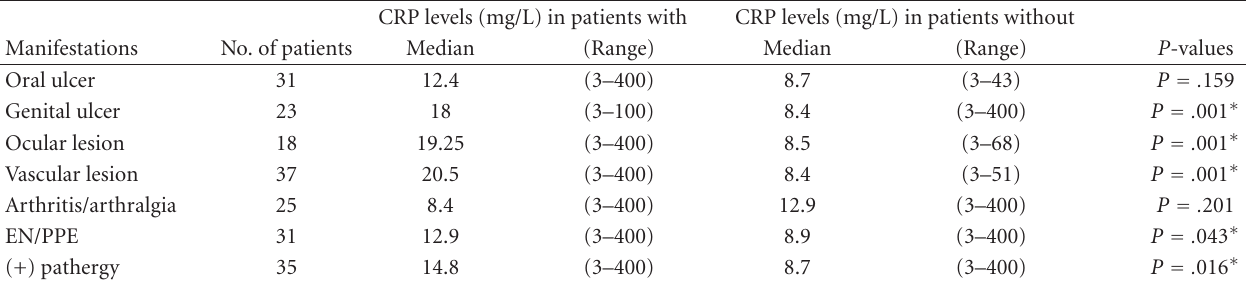
Table 5: The significance of the association of CRP with versus without individual clinical manifestations and pathergy reaction.